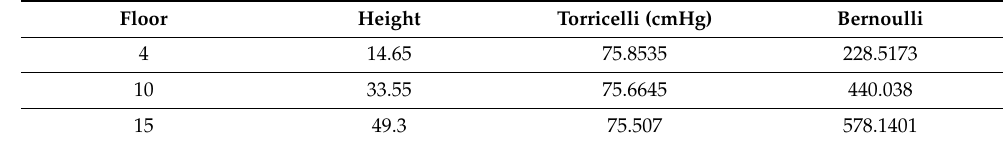
Table 6. Results of the Torricelli and Bernoulli equations.